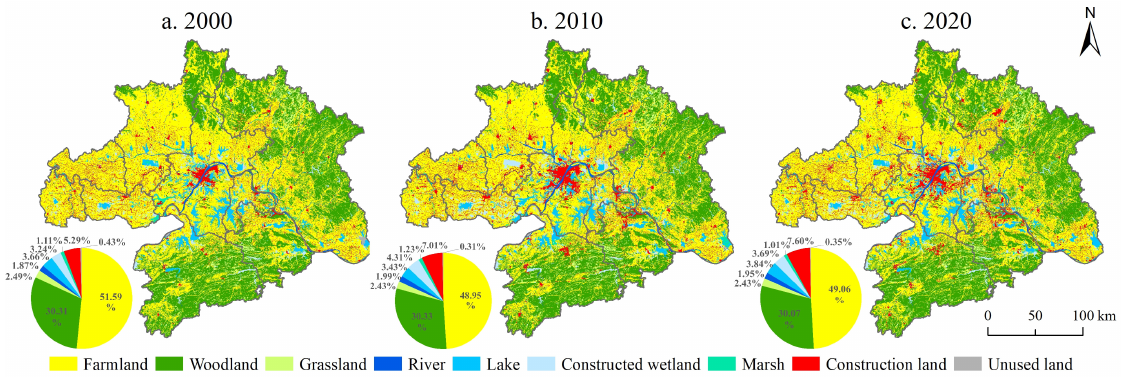
Figure 7. Distribution of land use in WUAA from 2000 to